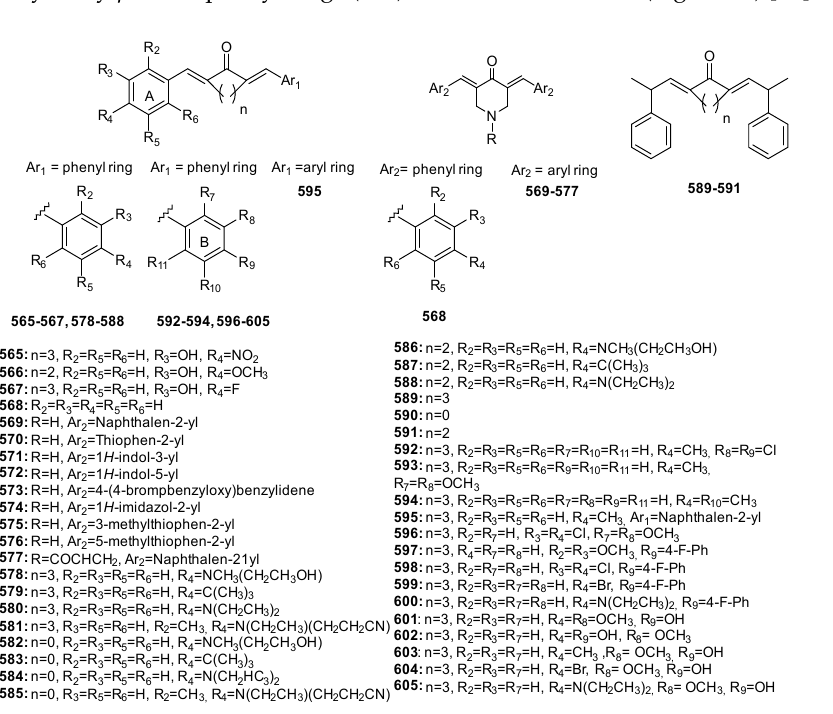
Figure 12. Diarylpentanoids with promising inhibitory effects in COX and LOX pathways.